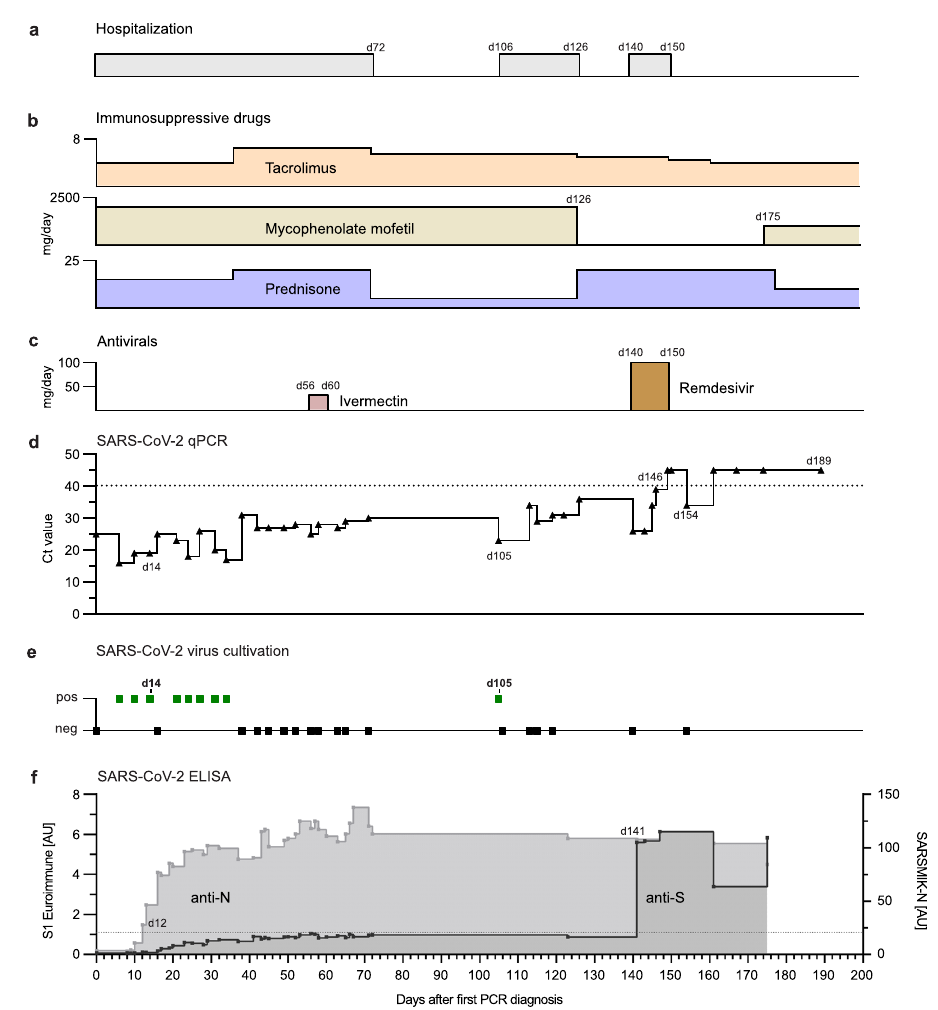
Fig. 1 Summary of the clinical course of the SARS-CoV-2-positive kidney transplant patient. Temporal overview of ( a ) hospitalization, ( b ) immunosuppressive treatment (daily dose in mg/day), and ( c ) antiviral therapy (daily dose in mg/day), Remdesivir was given 200 mg on the fi rst day and 100 mg/day 2 to 10. d Diagnostic SARS-CoV-2 RT-qPCR cycle threshold (Ct) values of oropharyngeal swabs over time. Day 0 indicates the fi rst positive RT-qPCR result in March 2020, 12 days after kidney transplantation. The dotted line indicates the cutoff value (Ct ≥ 40) between positive and negative results. e Attempts of virus isolation from oropharyngeal swabs. f Detection of spike S1-subunit- and nucleoprotein (N) speci fi c antibodies by ELISA. The dotted line indicates the anti-S1 ELISA cutoff at 1.1 arbitrary unit